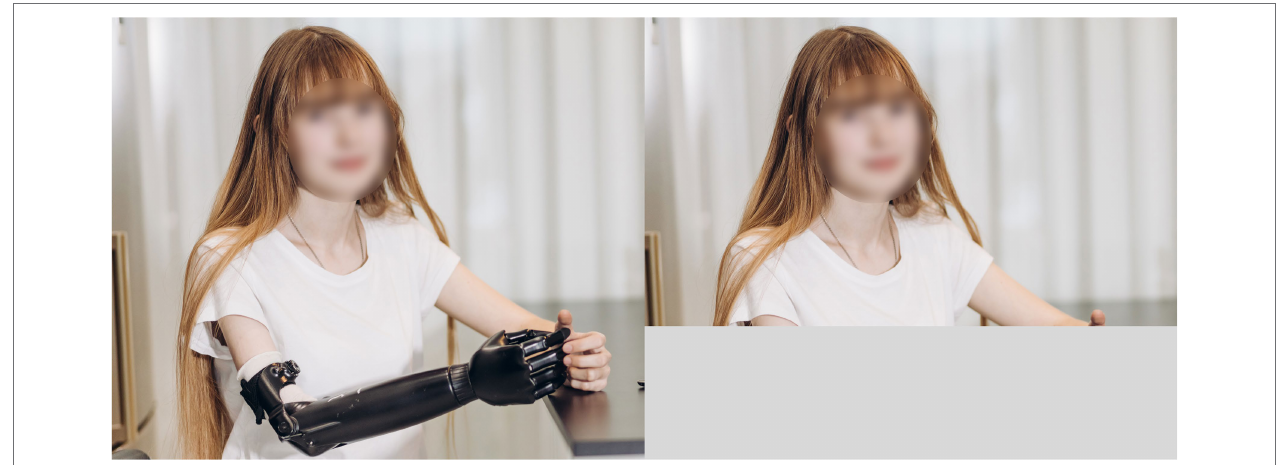
FIGURE 1 | Example of stimuli with disability (left) and without disability